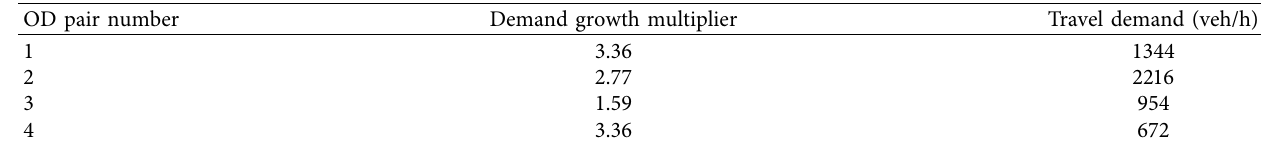
Table 13: Travel demand of OD